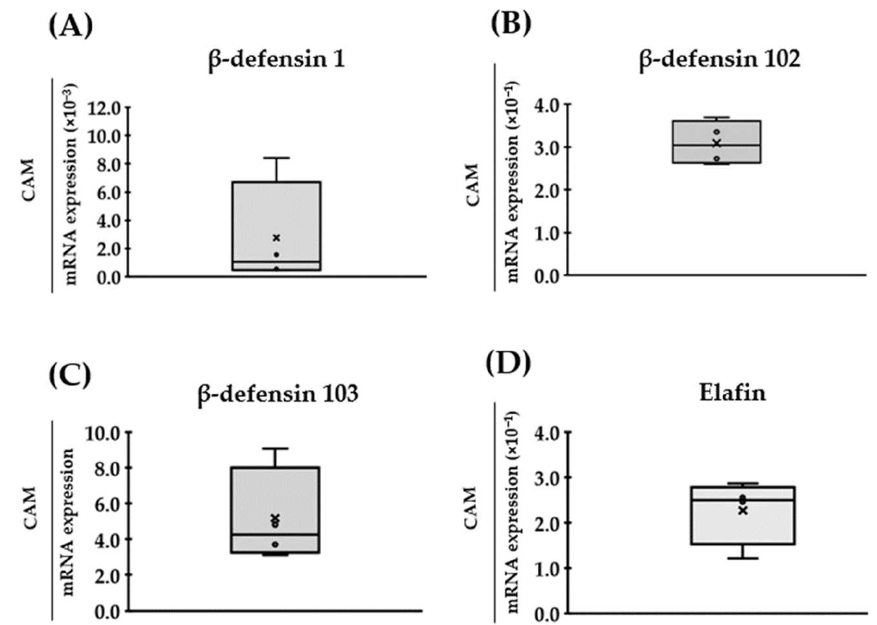
Figure 2. Box plots of Cq value distribution of RT-qPCR; ( A ) β -defensin 1, ( B ) β -defensin 102, ( C ) β -defensin 103, and ( D ) Elafin. Y -axis demonstrates relative mRNA expression between gene of interest and reference gene.